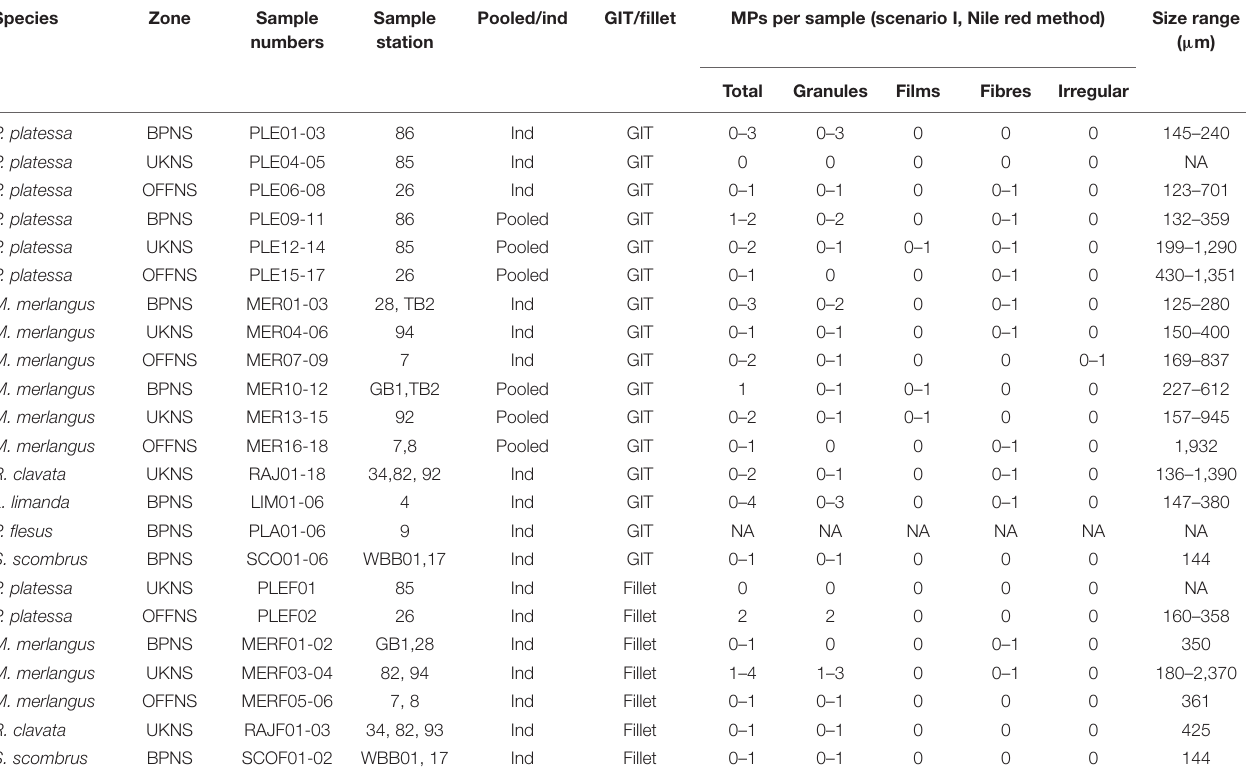
TABLE 2 | Number of MPs (range) for each sample type per shape for fish GIT and fillet blank samples (scenario i, Nile red observations) (NA–not applicable).